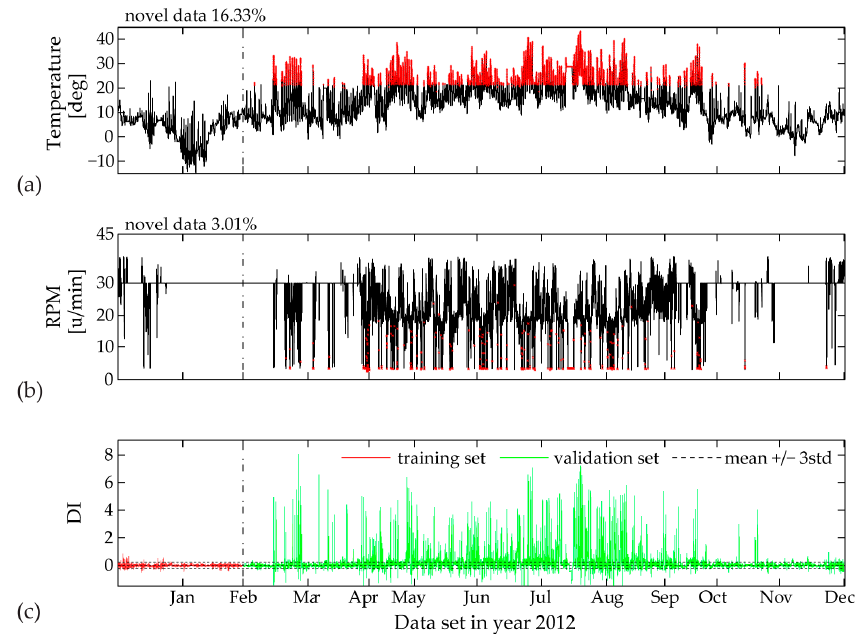
Figure 19. Two-month training set: ( a ) Identified novel data (red points) within time history of 10-min mean values of measured temperature; ( b ) Identified novel data (red points) within time history of 10-min mean values of measured RPM; ( c ) Diagnostic Index for the complete data sets of year 2012.